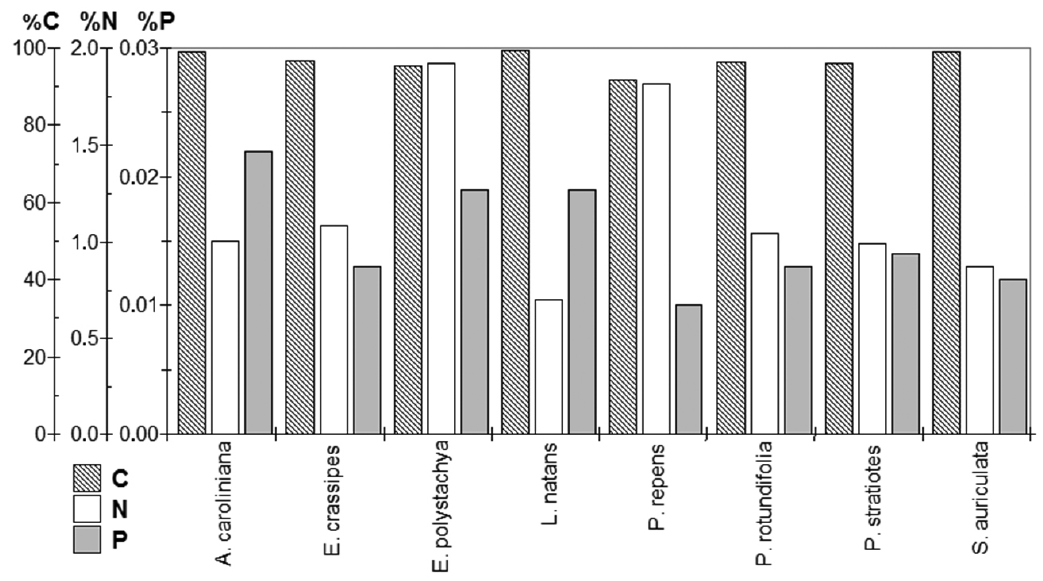
Figure 6. Percentage of dry weight of carbon, nitrogen and phosphorus in eight species of aquatic macrophytes found in the Catalão Lake, Central